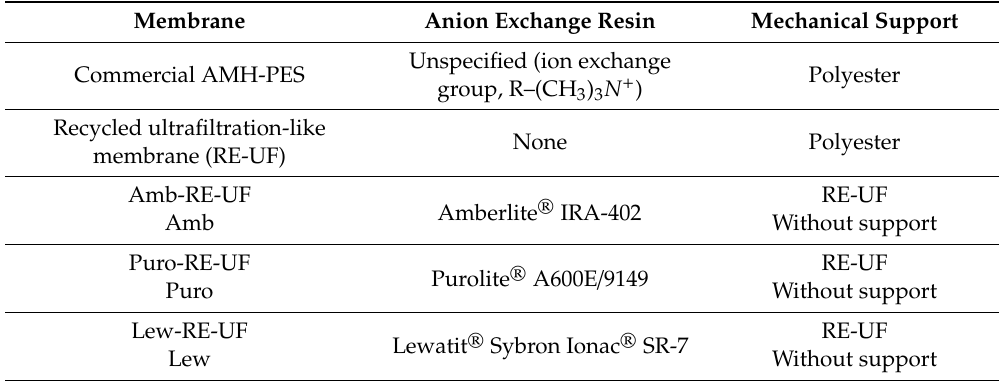
Table 2. Summary of the analyzed